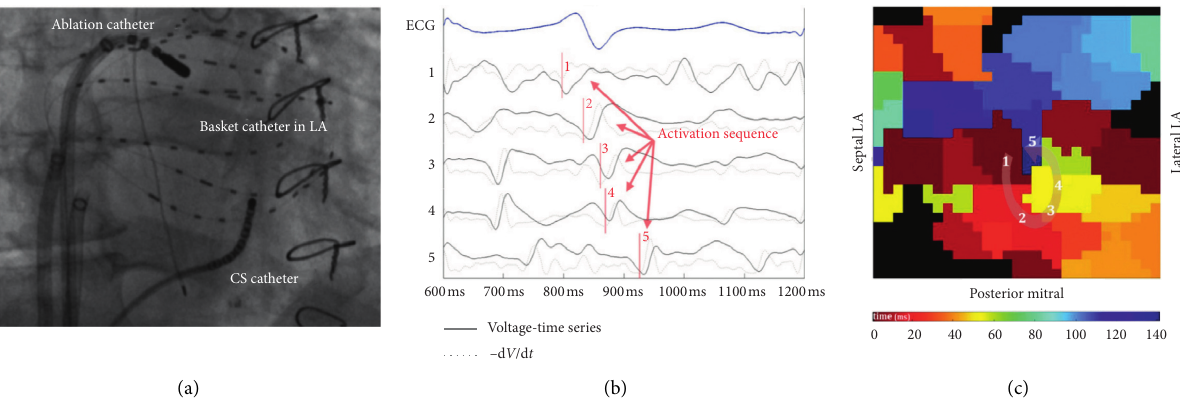
Figure 9: FIRM mapping. (a) The 64-pole basket catheter in the left atrium. (b) ECG (blue) and unipolar intracardiac signals (black) from the 64-pole basket catheter. (c) Isochronal activation map reconstructed from the corresponding electrograms, illustrating a left atrial rotational activity (from Baykaner et al. [51]).